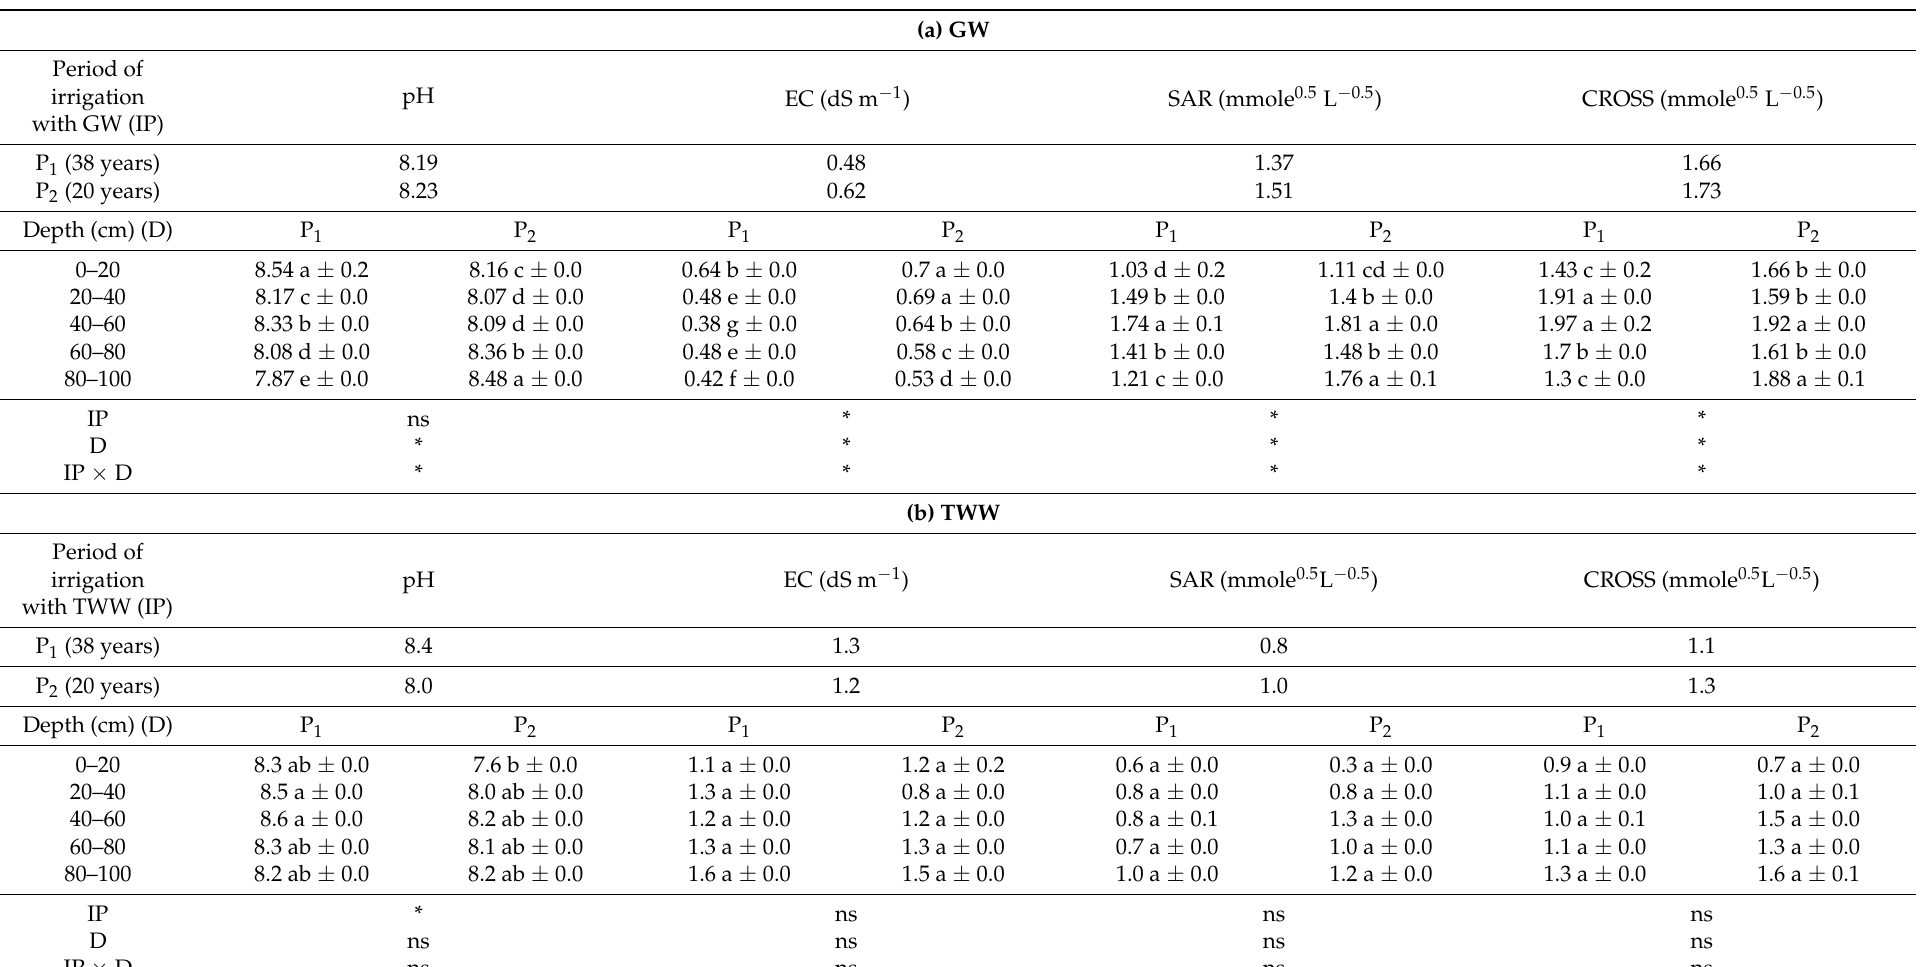
Table 4. Changes in soil pH, CE, SAR, and CROSS according to soil depth and period of irrigation with GW (a) and TWW (b) in P 1 and P 2